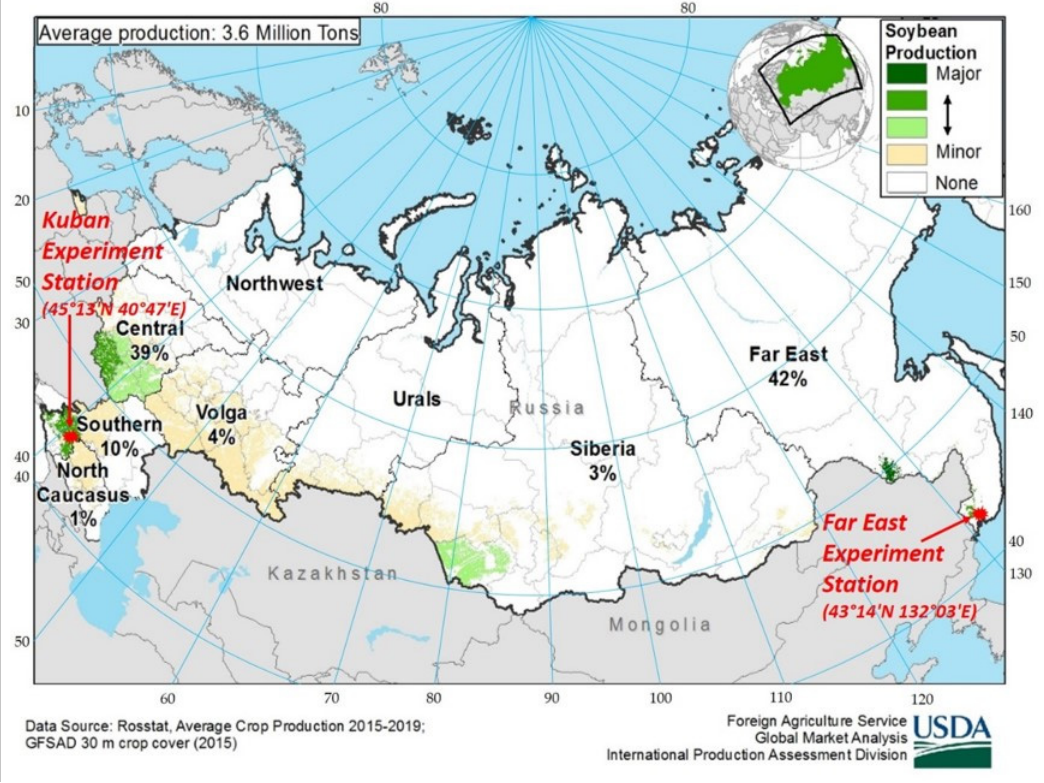
Figure 1. Soybean production in Russia. Map is taken from [11], modified.